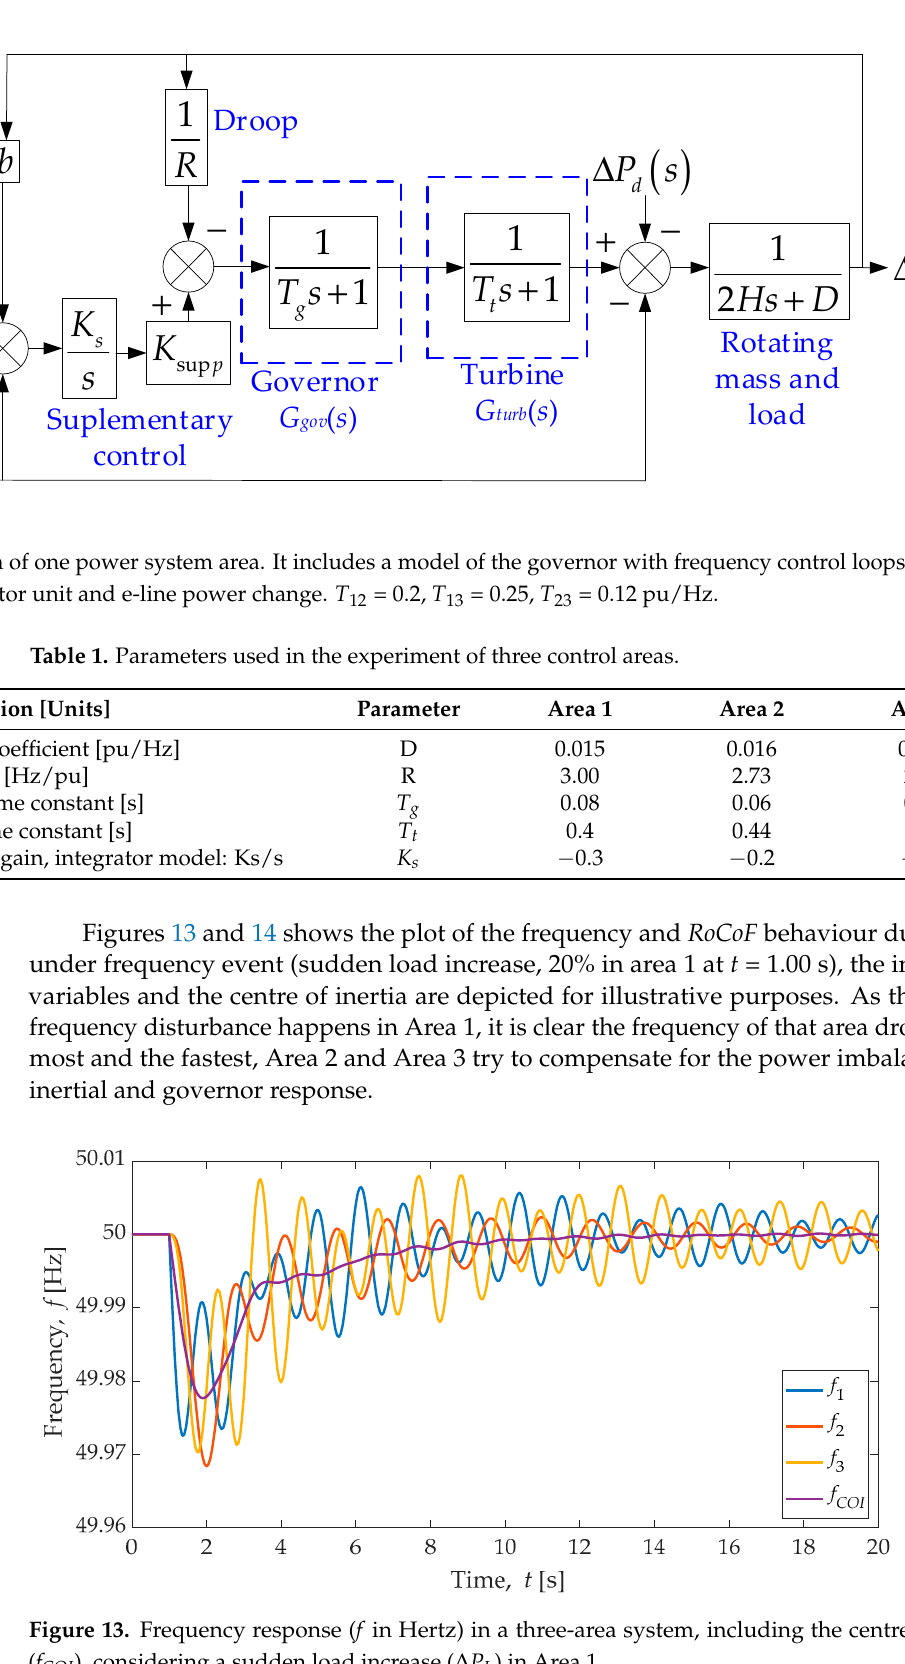
Figure 14. Rate-of-Change-of-Frequency ( ROFOF in Hertz/s) in a three-area power system including the centre of inertia ( f COI ) , considering a sudden load increase ( Δ P L ) in Area 1. During an under frequency event, as shown in Figures 13 and 14, the synchronous generators accelerate/decelerated depending on different speeds (depending on the iner- tia, instantaneous active power imbalance and governors characteristics), the frequency of centre of inertia represents and is averaged values of the frequency considering the individual inertias as a weighting factor. Although the main control and protection equip- ment are designed to operate based on local frequency, the frequency of inertia centre is used, typically, as a global indicator to assess the frequency response of a multi-machine power system. This experiment demonstrates how the frequency in each control area might be dif- ferent during the under-frequency event. However, the frequency of the centre of inertia can be used as an indicator when assessing the system frequency response of a system. However, it must be noticed that as a global indicator, the frequency of the centre of inertia tends to mask the local frequency variations. 6. Rate of Change of Frequency This section is specifically dedicated to one crucial indicator of the system frequency response, the RoCoF. The frequency is a crucial electromechanical indicator that reflects the balance between generation and demand, and the derivate or rate of change has many